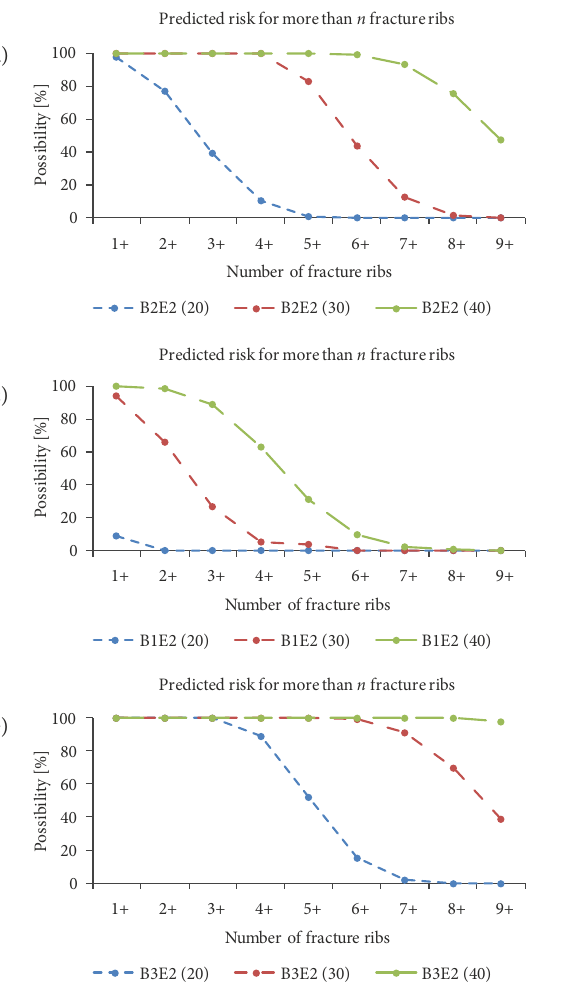
Figure 6. The influence of impact speed on chest injury (number of fractured